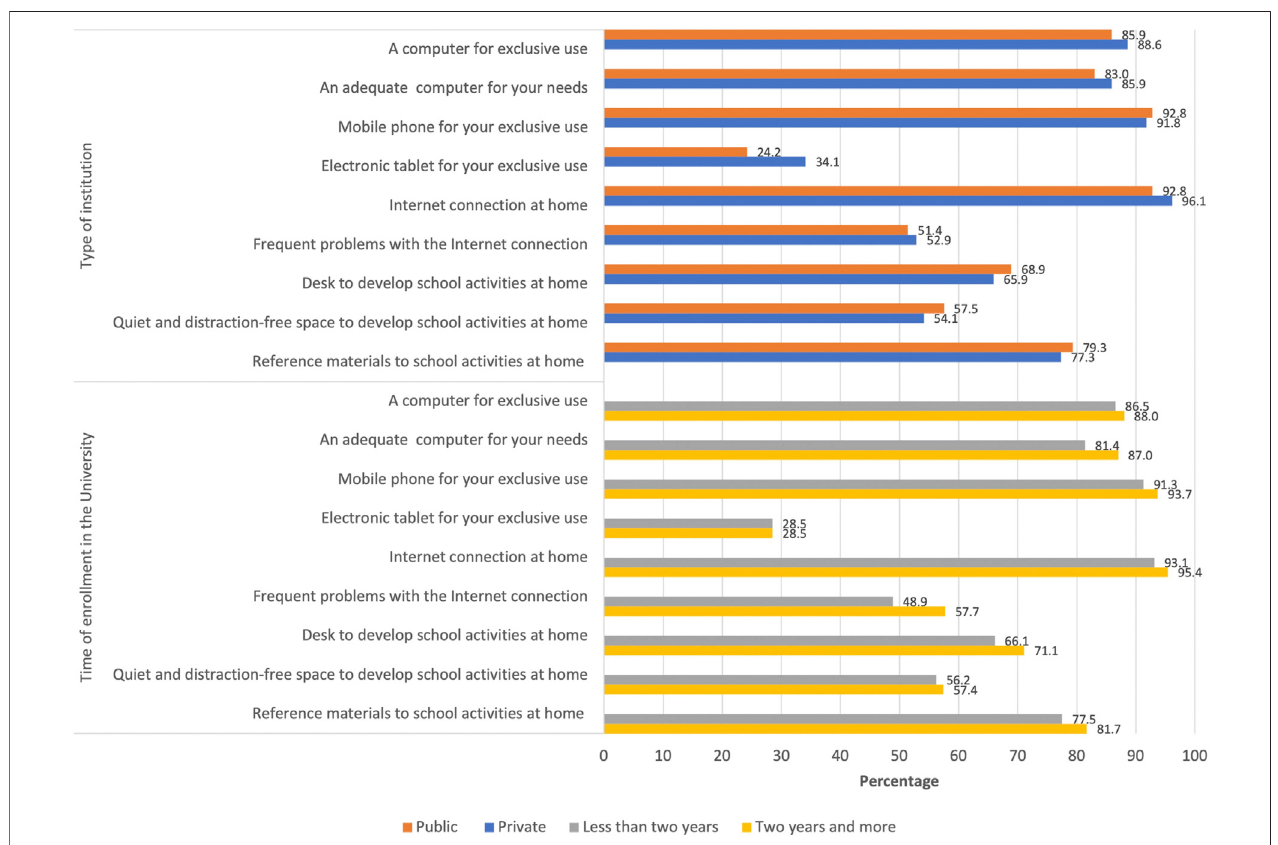
FIGURE 2 | Technological, connectivity, and logistical conditions among students, before the emergency remote teaching model implementation, by type of institution and time of enrollment in the